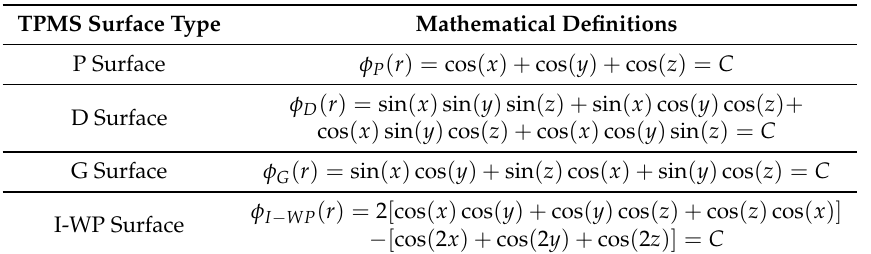
Table 1. Mathematical definitions of some common TPMS